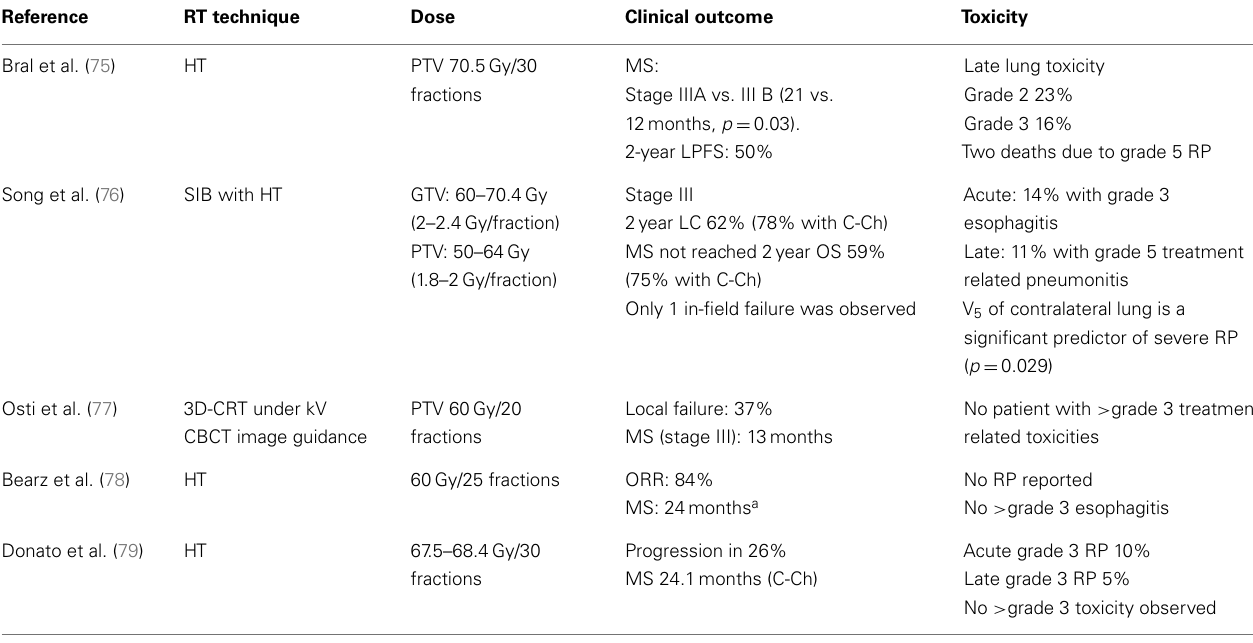
Table 2 | Chemo-IGRT for locally advanced NSCLC